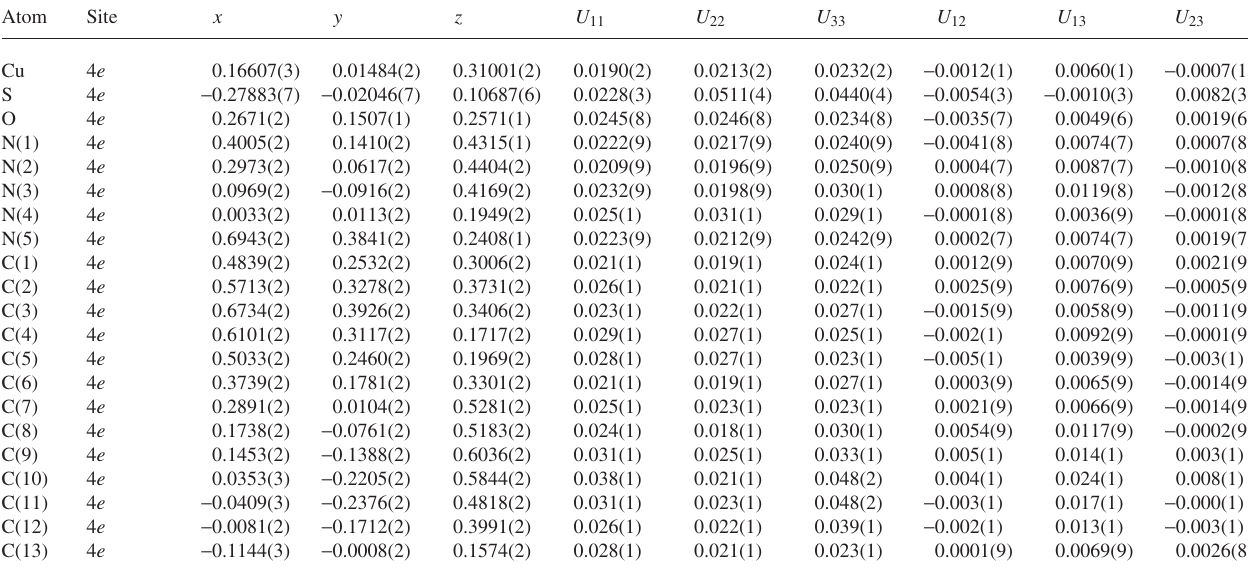
Table 3. Atomic coordinates and displacement parameters (in Å 2 )